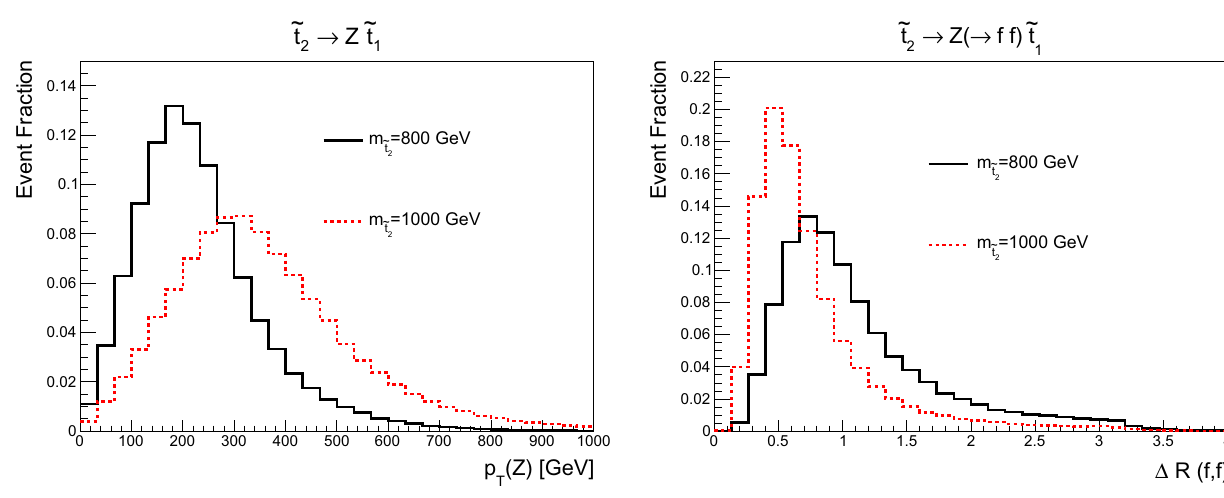
= 500 GeV and m ˜ = 800 / 1000GeV. Right the t 2 1